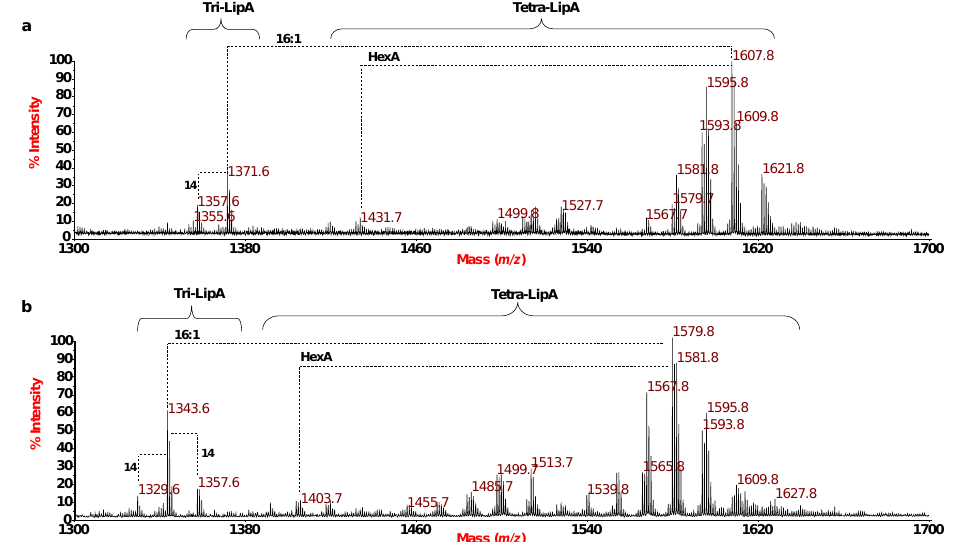
Figure 1. Reflectron MALDI-TOF mass spectra, recorded in negative polarity, of lipid A from E. pacifica KMM 6172 T ( a ) and E. vietnamensis KMM 6221 T ( b ) obtained after acetate buffer treatment of each LPS. The lipid A species are labelled as Tri- and Tetra-Lip A indicating the degree of acylation. “HexA” indicates the hexuronic acid (i.e., the D